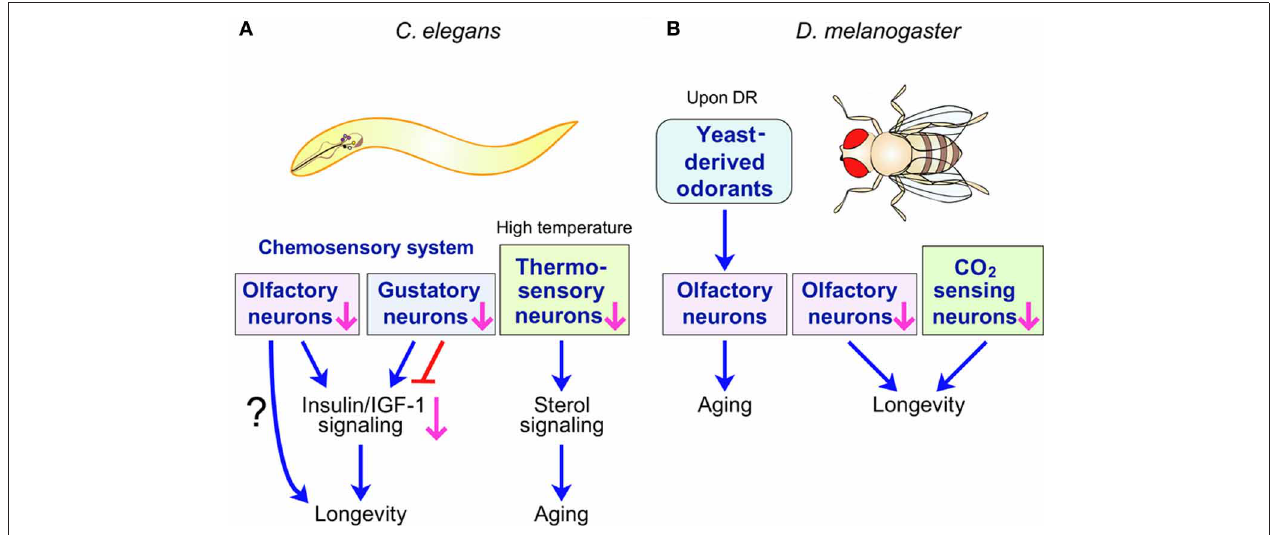
signaling pathway. (B) Chemosensory systems regulate D. melanogaster lifespan. Olfaction of nutrient-derived odorants promotes the aging of long-lived D. melanogaster upon dietary restriction (DR). Perturbation of the D. melanogaster olfactory system and inhibition of the CO 2 -sensing